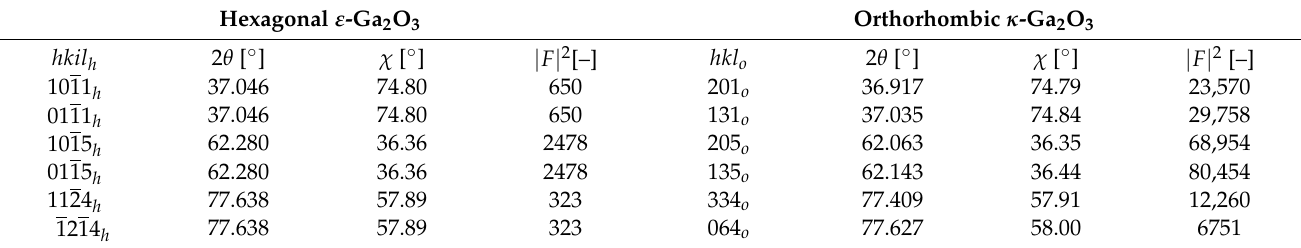
Table 1. Three selected diffractions of hexagonal ε -Ga 2 O 3 (left panel) and their counterparts in orthorhombic κ -Ga 2 O 3 (right panel). 2 θ is the diffraction angle, χ is the inclination angle with respect to the sample normal, and | F | 2 is the calculated modulus squared structure